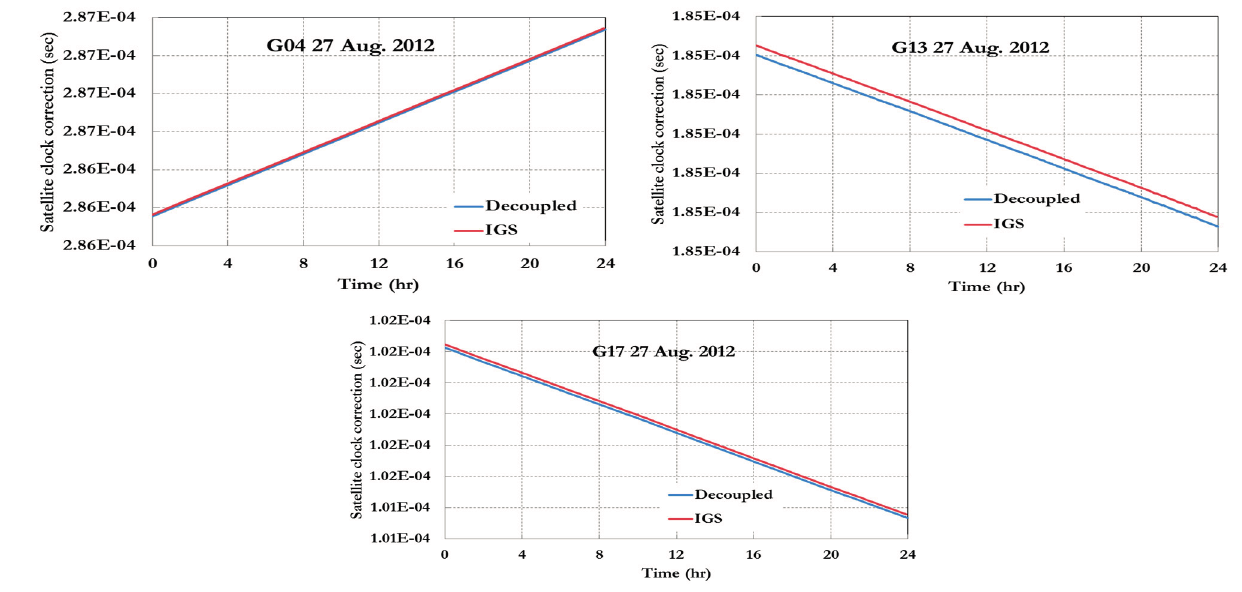
Figure 4. IGS and decoupled clock corrections 27 August 2012.